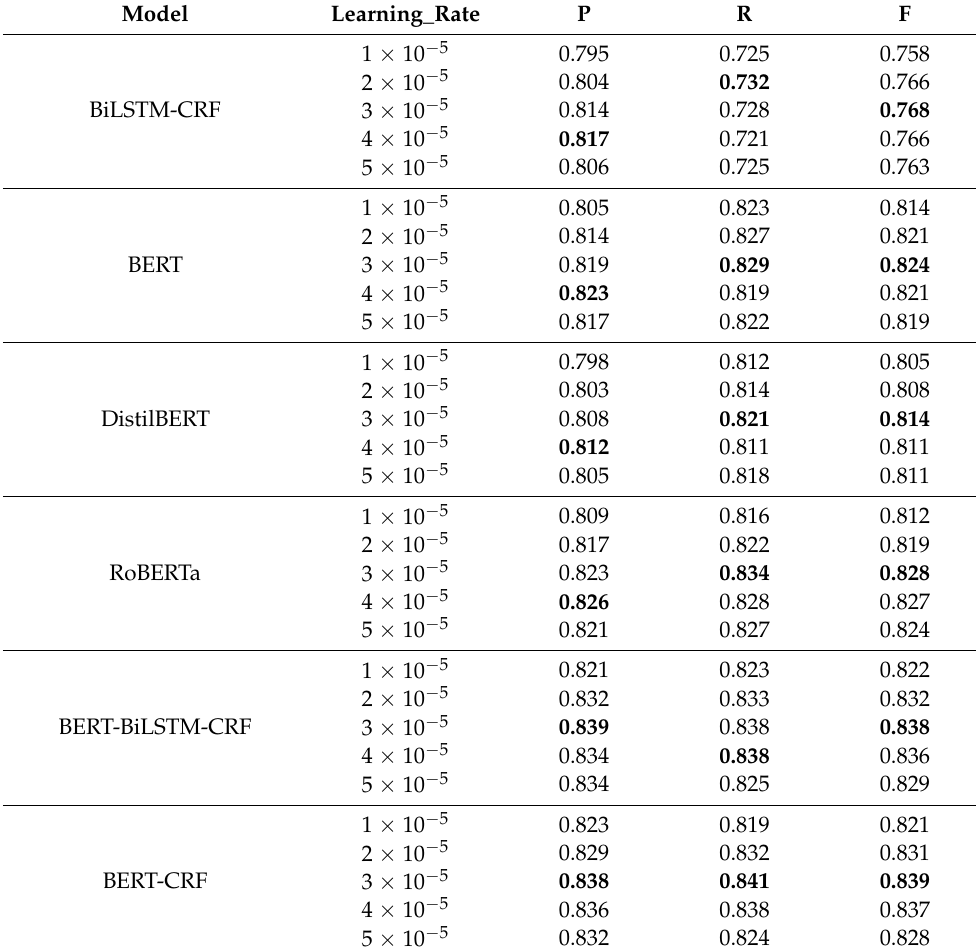
Table 5. P, R and F1 scores of the model under different learning rates. The numbers in bold font are the three indicators (P, R, F1) with the highest corresponding scores in each set of experiments.